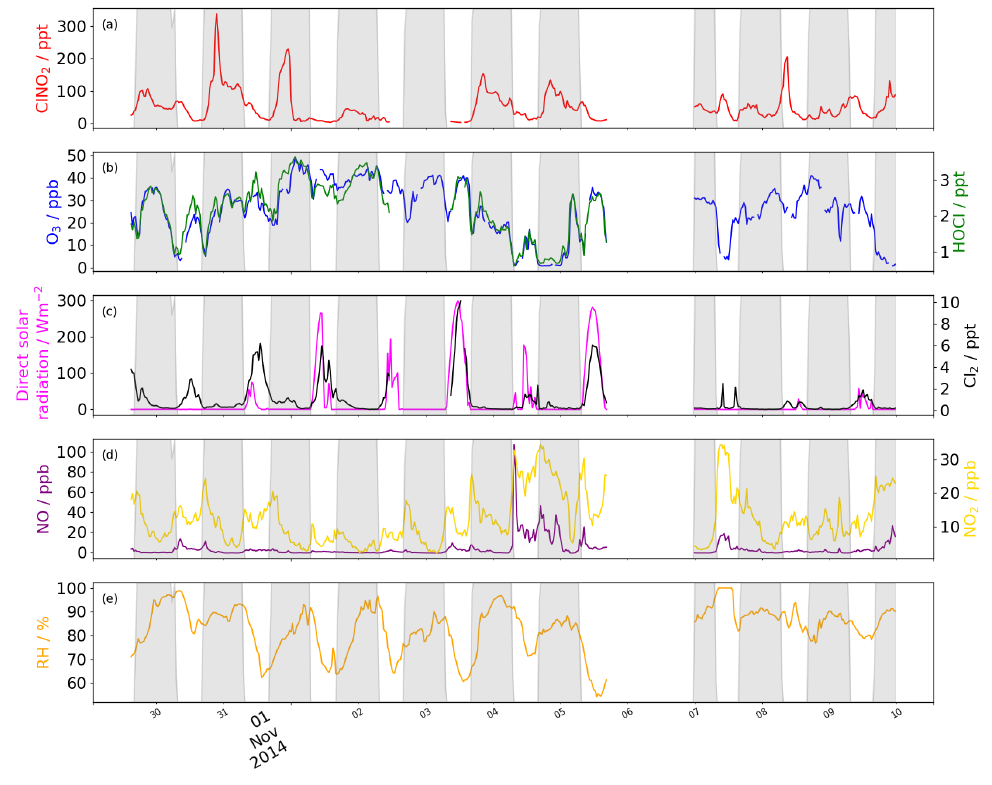
Figure 1. Time series of (a) ClNO 2 (ppt), (b) HOCl (ppt) and O 3 (ppb), and (c) Cl 2 (ppt) and direct solar radiation (Wm − 2 ). (d) NO (ppb) and NO 2 (ppb). (e) Relative humidity (%). Data is removed during bonfire night (5–6) and HOCl data is discounted thereafter due to a persistent interference that was not present